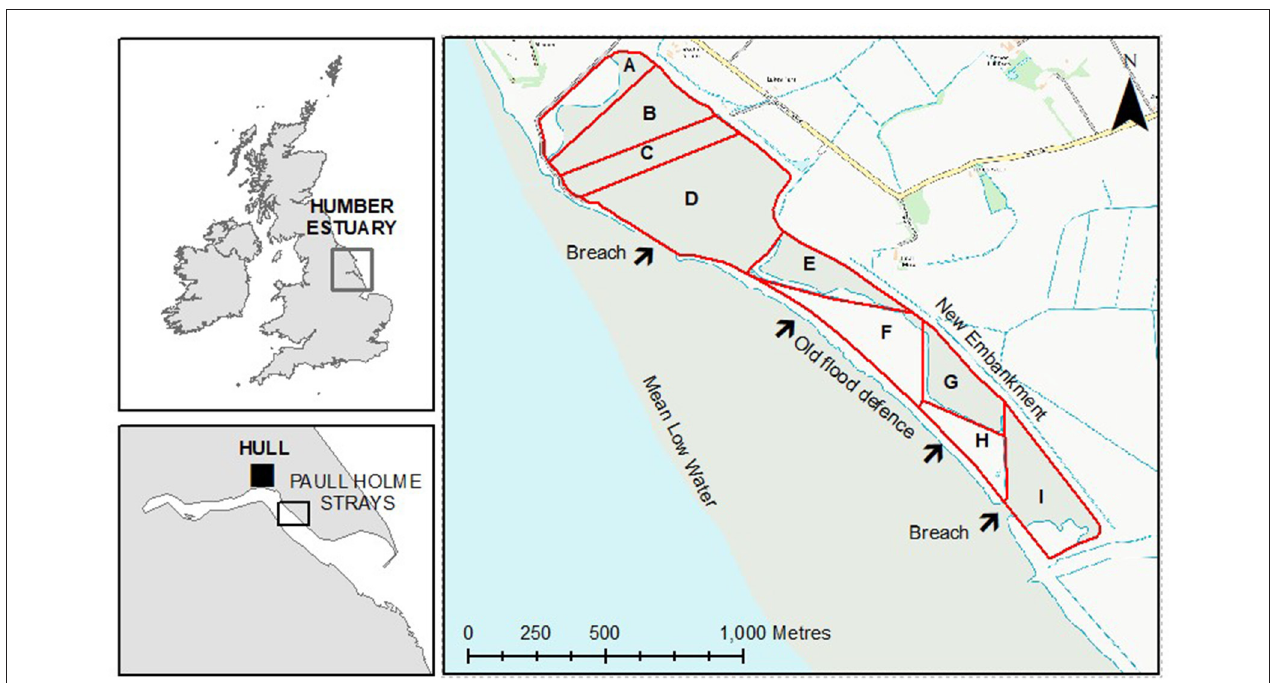
FIGURE 1 | Location of the Paull Holme Strays managed realignment (MR) site on the Humber Estuary and sectors